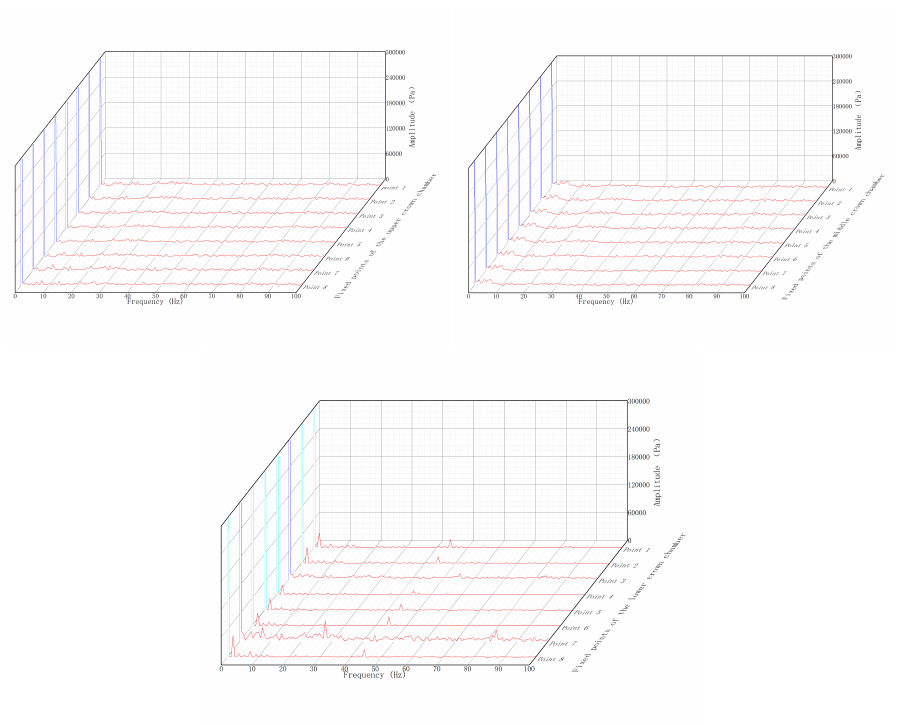
Figure 20. The pressure fluctuations of the upper, middle, and lower crown